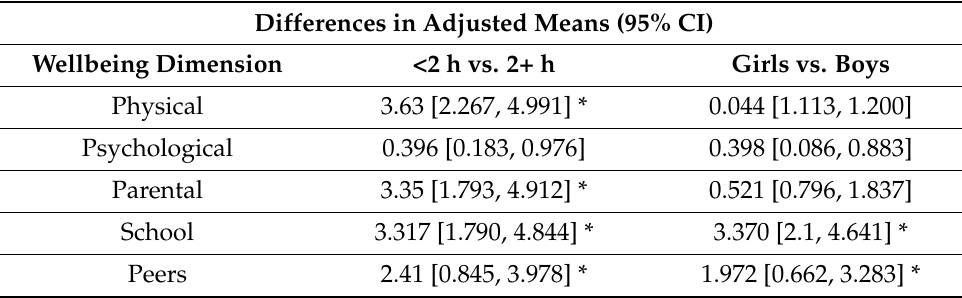
Table 3. Pairwise contrasts for adjusted means for five wellbeing